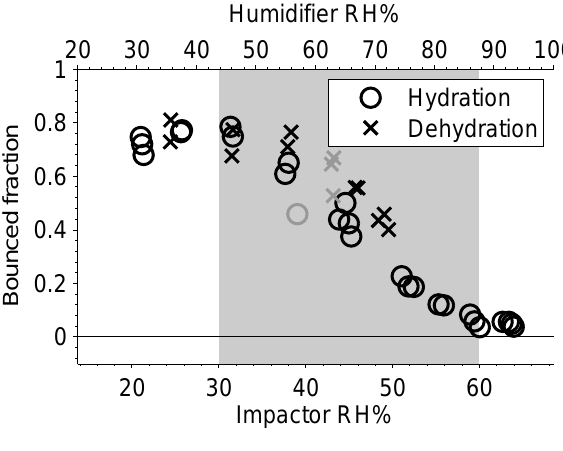
Fig. 5. Bounce fractions of levoglucosan aerosol at hydration and dehydration experiments. The first humidifier was kept above 75% RH for the ERH run. The gray patch indicates the transitional area from solid to liquid, reported by Mikhailov et al. (2009). Bounced fraction is corrected according to Eq. (1). The gray open symbols denote downscan points , to show the effect of loading of the sub-